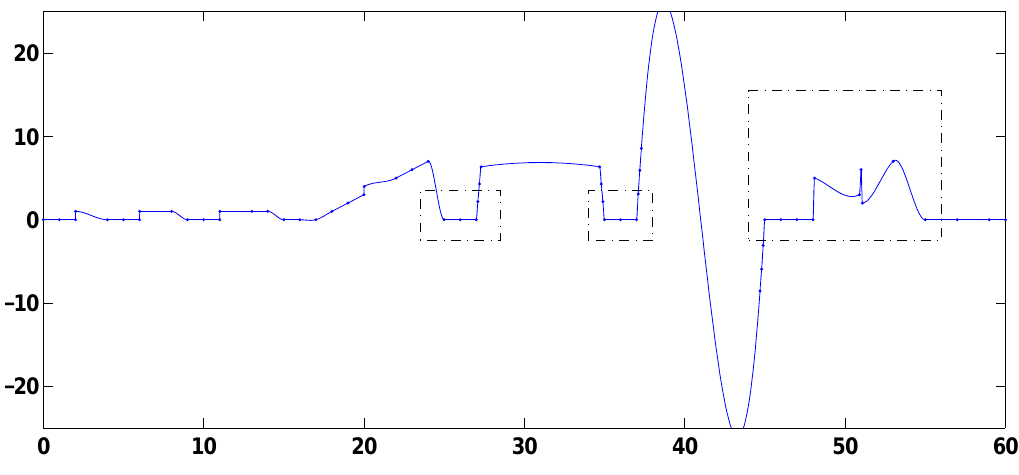
Figure 9 . Function-value-based 7-point-window L